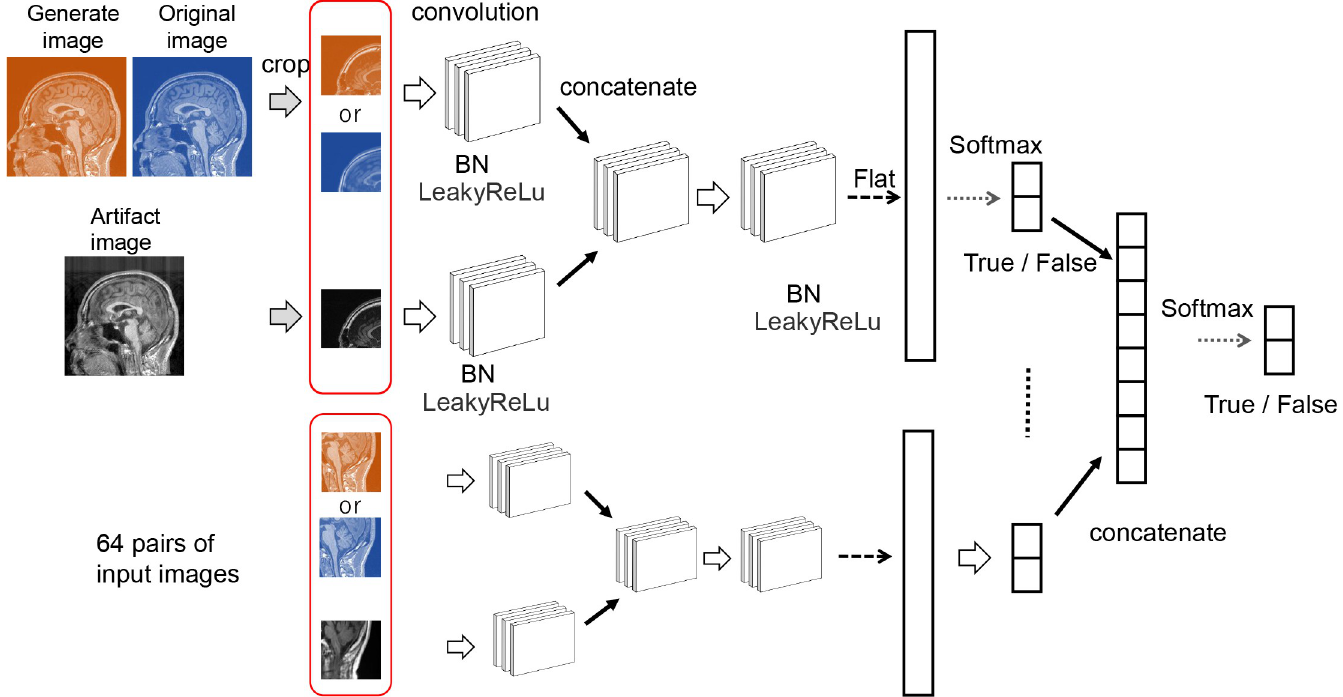
Fig 5. Discriminator network. PachGAN was used as the Discriminator network. First, the input image was cropped into small regions (patch size). Secondly, for each small region, binary classification was performed by a network consisting of a convolutional layer, an activation layer (LeakyReLu, Softmax), a batch normalization layer (BN), and an affine layer (Flat). Thirdly, the outputs of the binary classification in all subregions were combined. Finally, binary classification was performed using the Softmax function to evaluate whether the two input images were entirely equal.